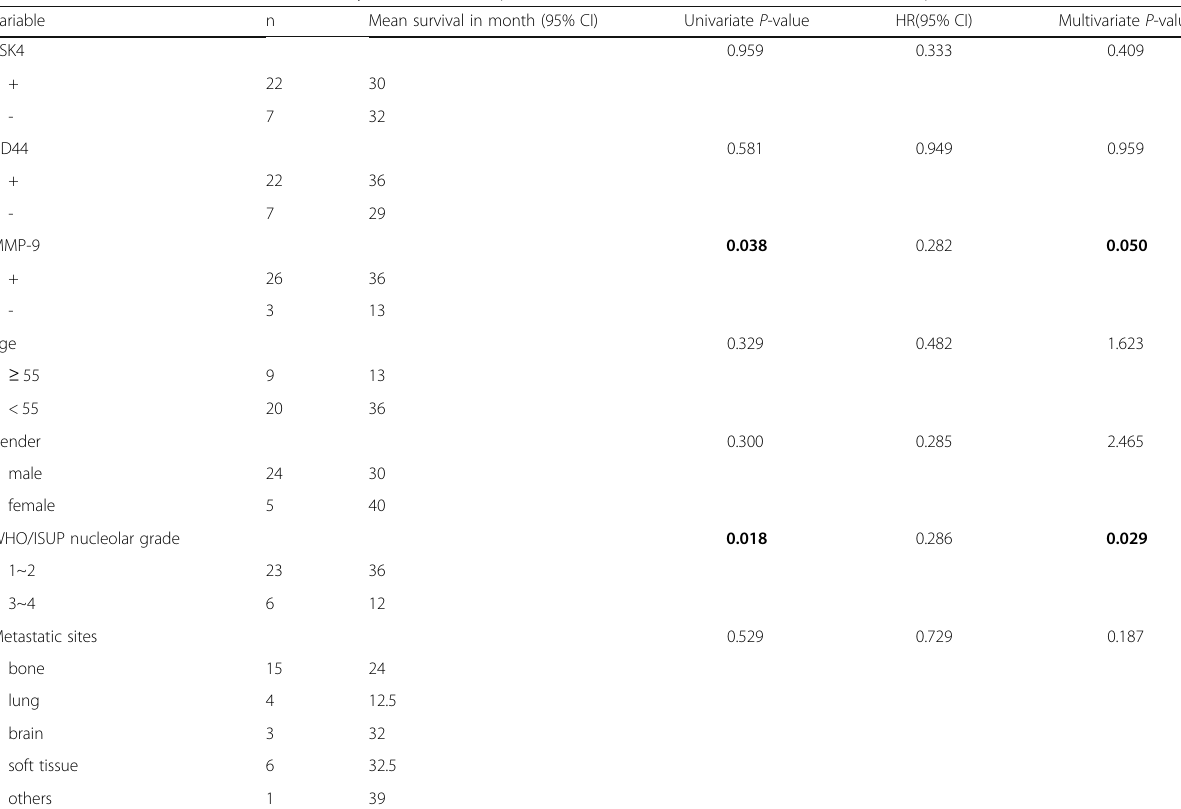
Table 4 Univariate and multivariate analysis of disease-specific survival in 29 mRCC cases with follow-up information